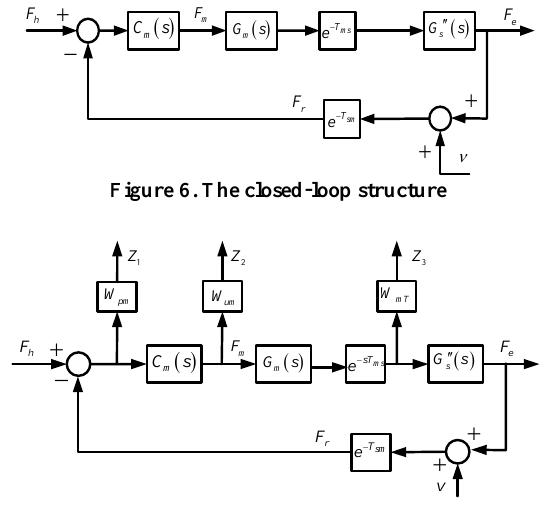
Figure 7. The structure of local master controller design.